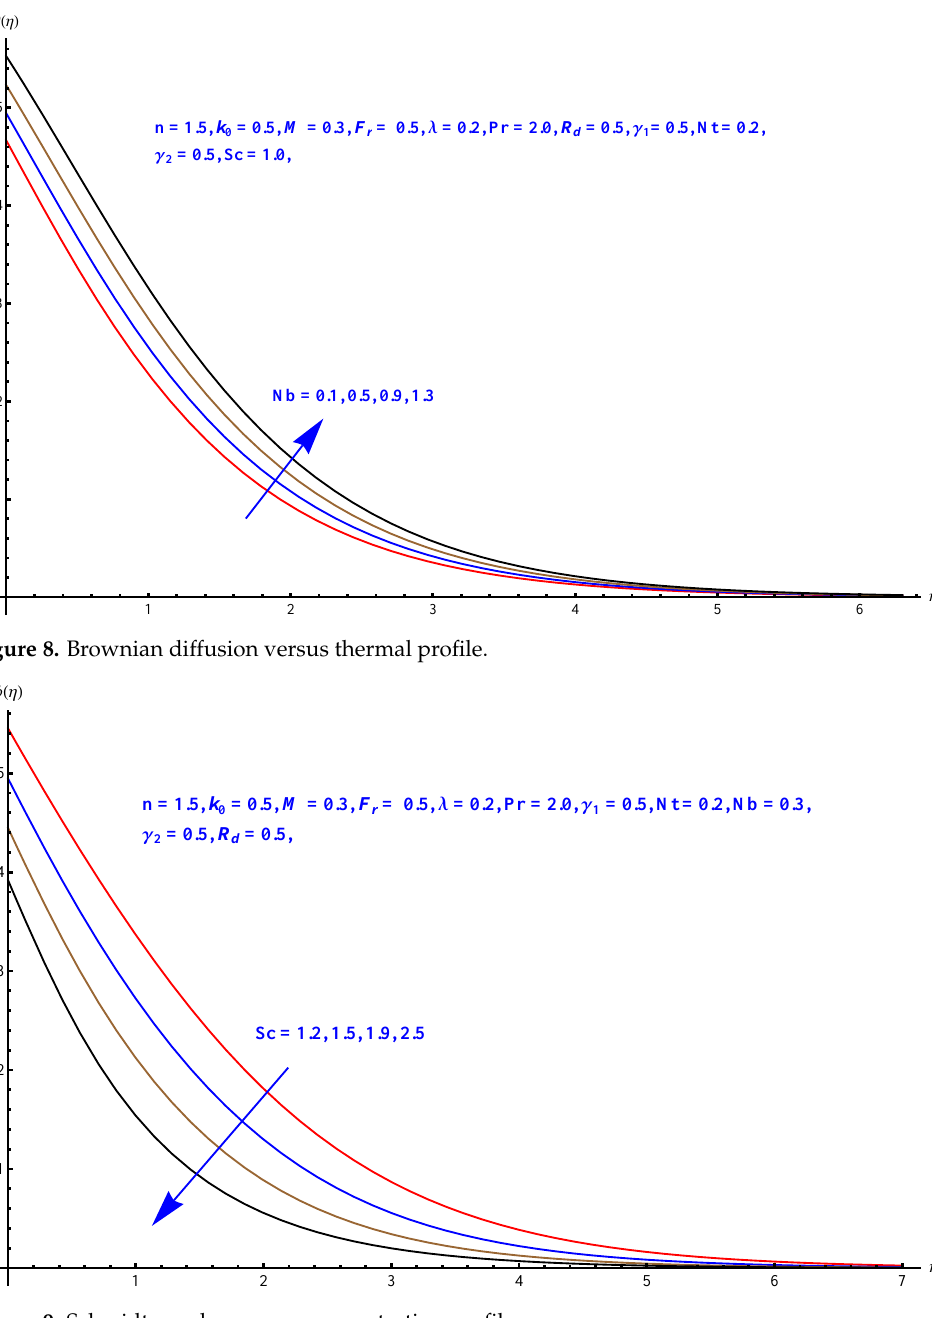
Figure 9. Schmidt number versus concentration